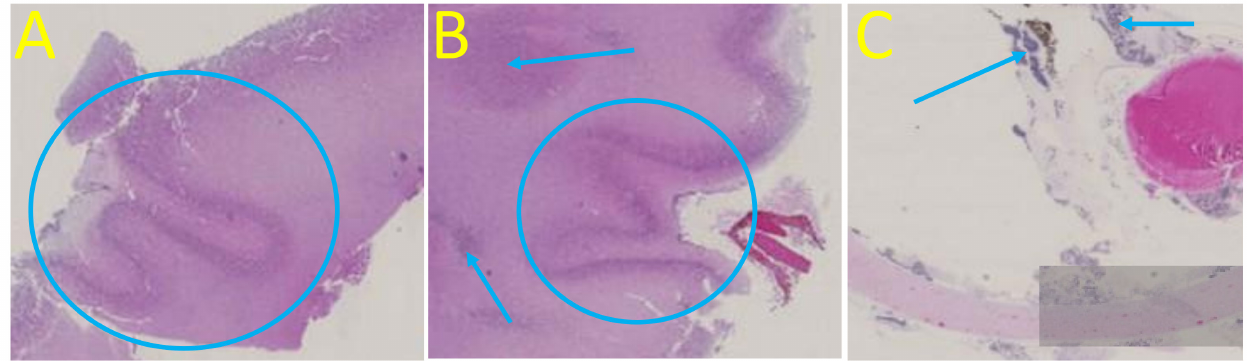
Figure 4. Post-mortem cerebral and ocular examination, hematoxylin and eosin staining, original magnification x10. ( A ) Right occipital cortical plate with polymicrogyria and extreme thinning of the subplate. ( B ) Right temporal polymicrogyria with lamina dissecans, heterotopic neurons (arrow), and periventricular nodule (blue circle). ( C ) Chorioretinal scars (arrows) with hyperpigmentation suggestive of chorioretinitis on the right optic disc.